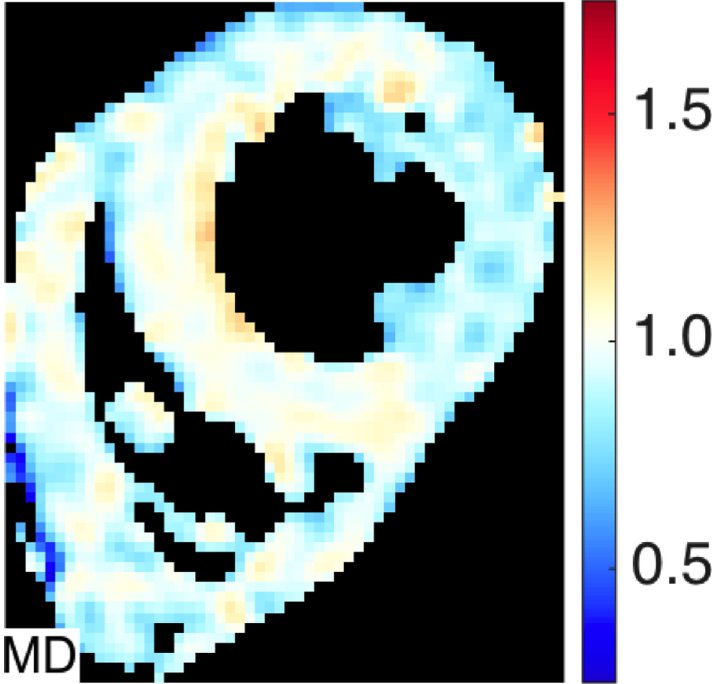
Fig 6. Typical Mean Diffusivity (MD) map. There is a subtle increased in the septal MD compared to the other regions.